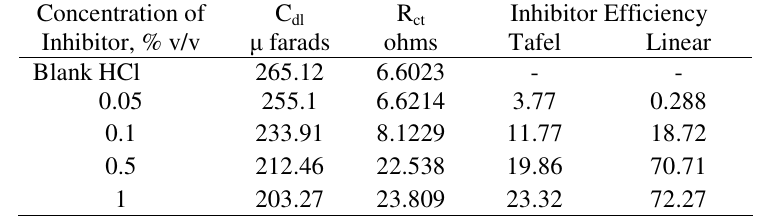
SO with and without NAL extract. 2 4 SO in the presence of 2 4